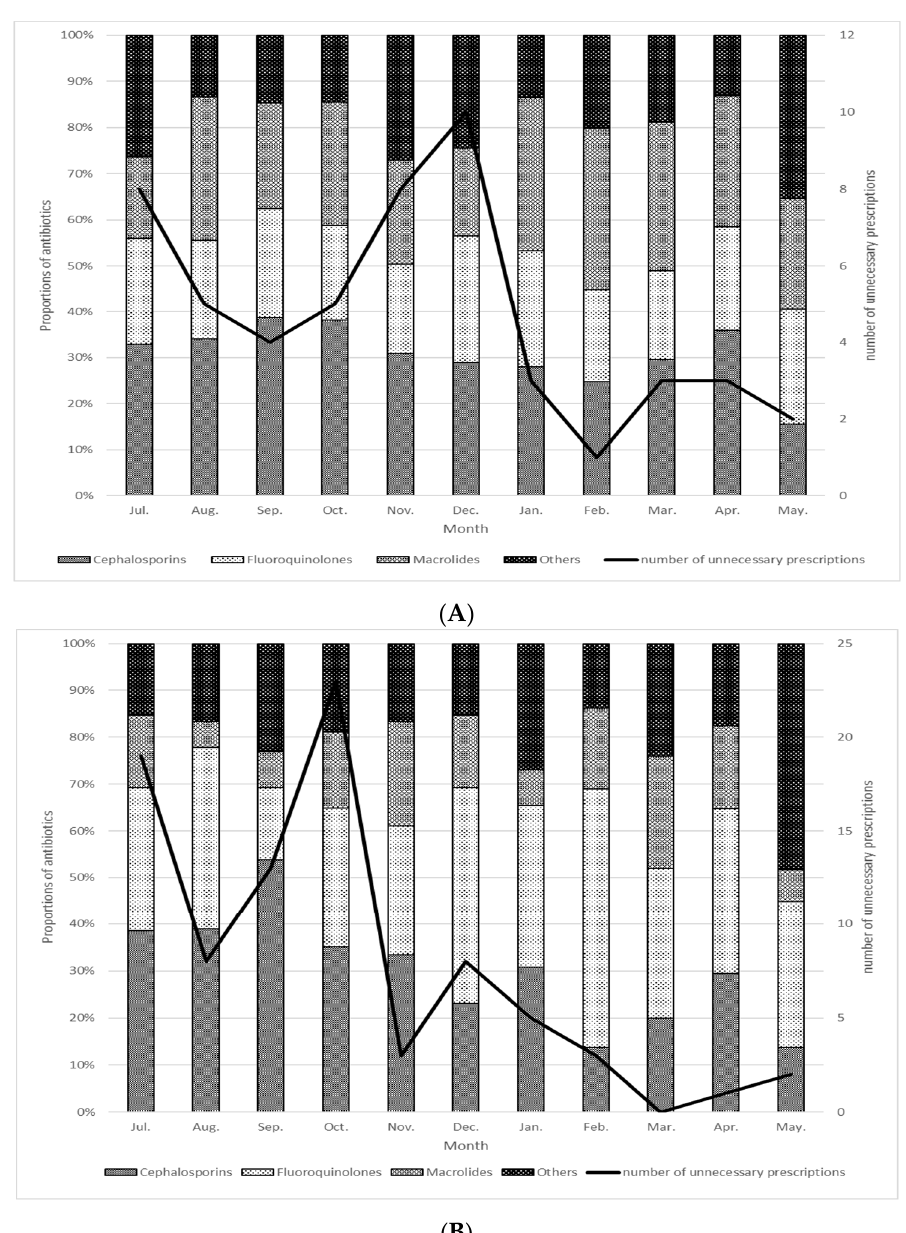
Figure 1. Distribution of antibiotics prescribed for acute respiratory tract infections ( A ) and acute diarrhea ( B ), 7 July 2020–May 2021 [6]. The bar graph shows cumulative percentage of oral antimicrobial agents by category. The line graph shows the change in the number of unnecessary antimicrobial agent prescriptions. ( A ) Acute respiratory tract infections, ( B ) Acute diarrhea.